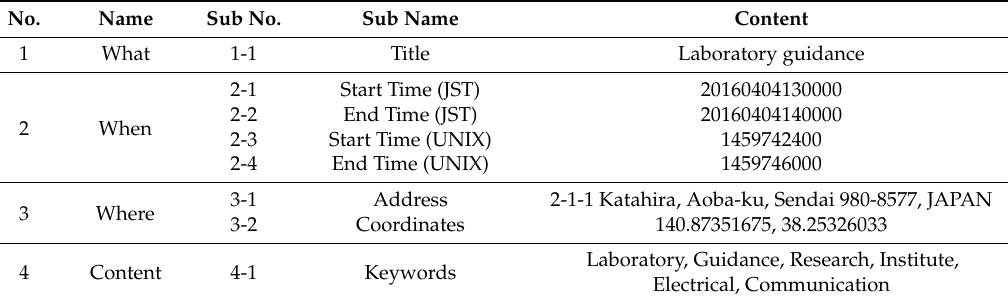
Table 5. Example of metadata used in an AIR (laboratory